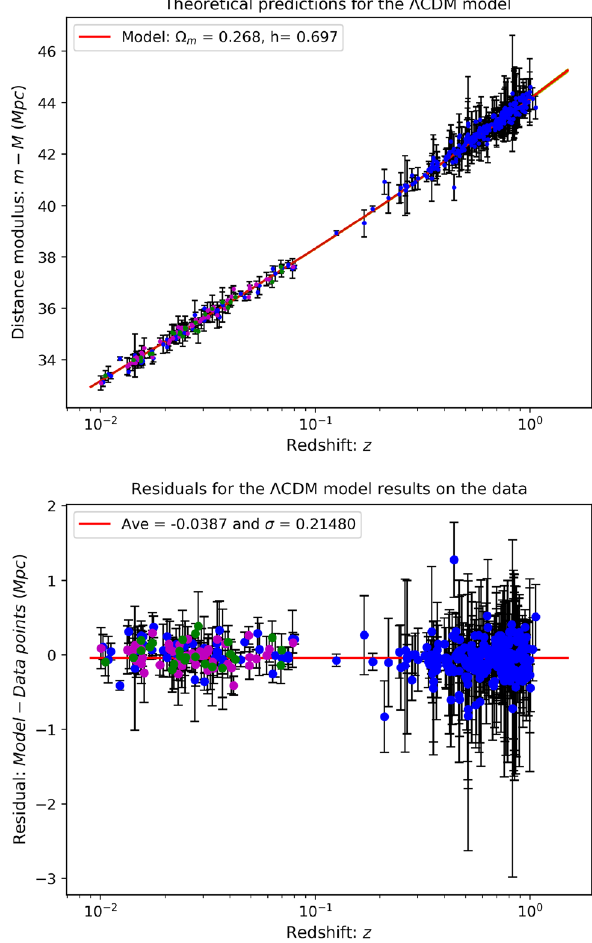
Fig. 2 The Λ CDM model’s best-fit to the Supernovae Type 1A data (top panel), with the cosmological parameter values as Ω m = 0 . 268 + 0 . 025 − (constrained) and H 0 = 69 . 7 + 0 . 5 − 0 . 024